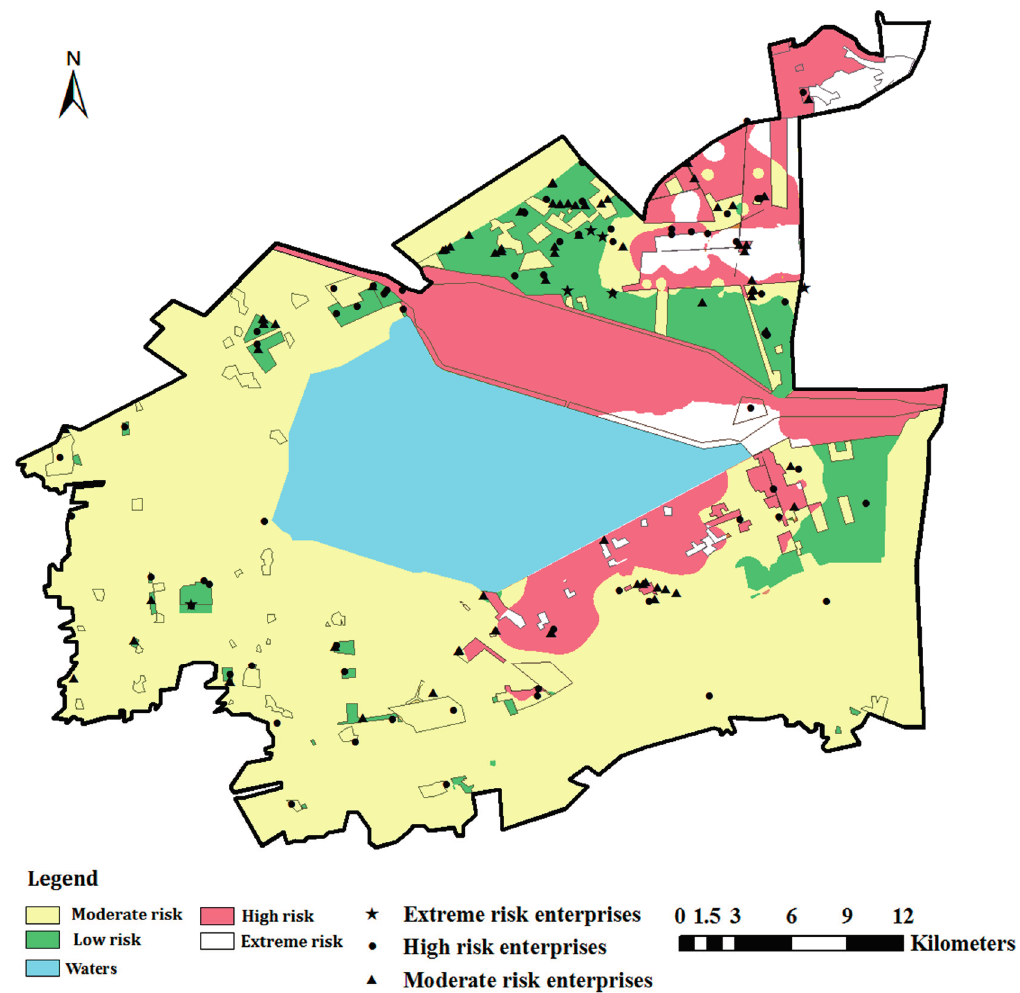
Figure 6. Spatial distribution map of the integrated